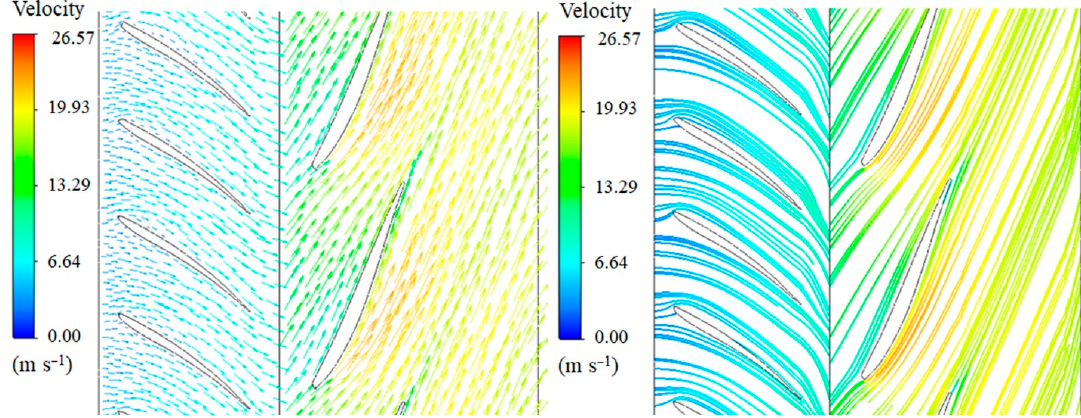
Figure 16. Blade-to-blade velocity vector and velocity streamlines (span = 0.5).